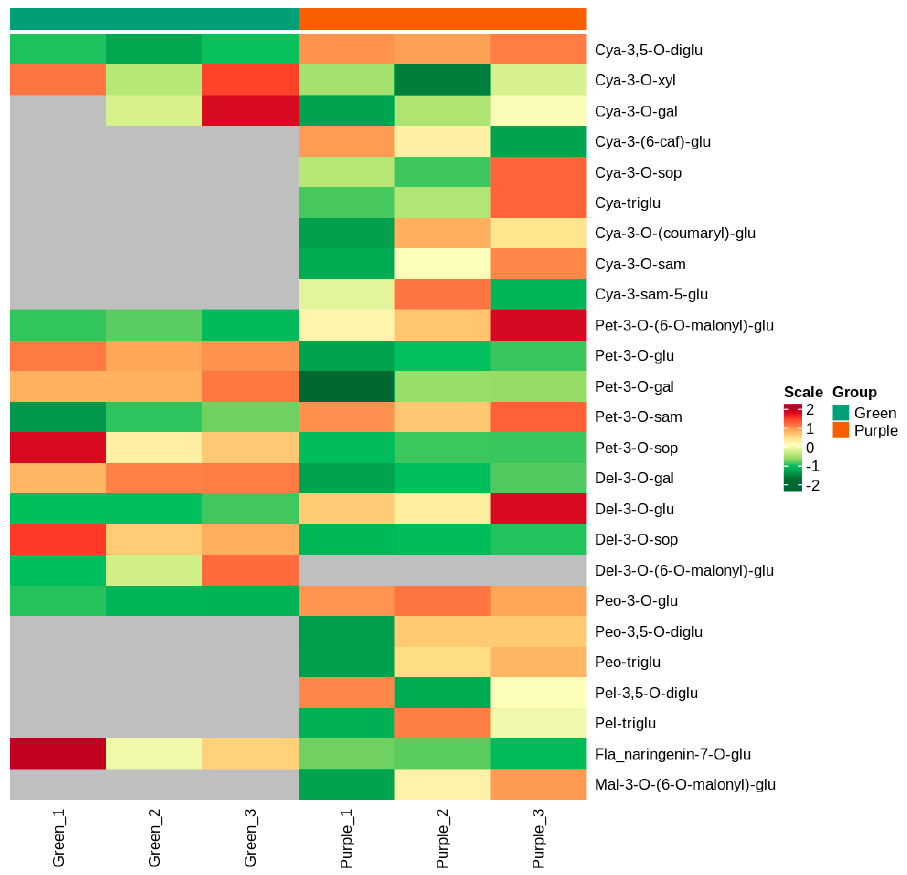
Figure 2. Cluster heatmap of metabolites between purple non-heading Chinese cabbage and its mutant. The x-axis shows sample information, the y-axis indicates the metabolite information, and the scale is the expression obtained after standardization.